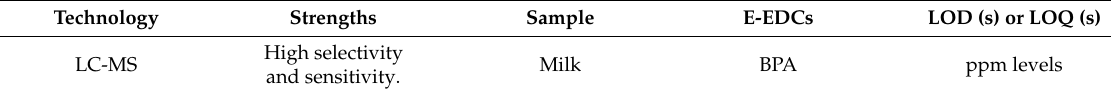
Table 3. Methods for determination of e-EDCs in milk and dairy